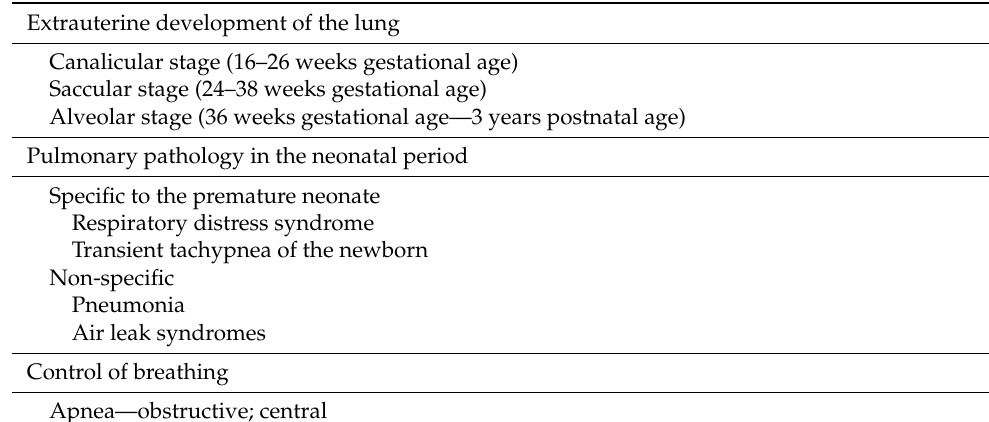
Table 1. Risks factors for pulmonary and respiratory sequelae in the premature neonates [8,18–23]. Extrauterine development of the